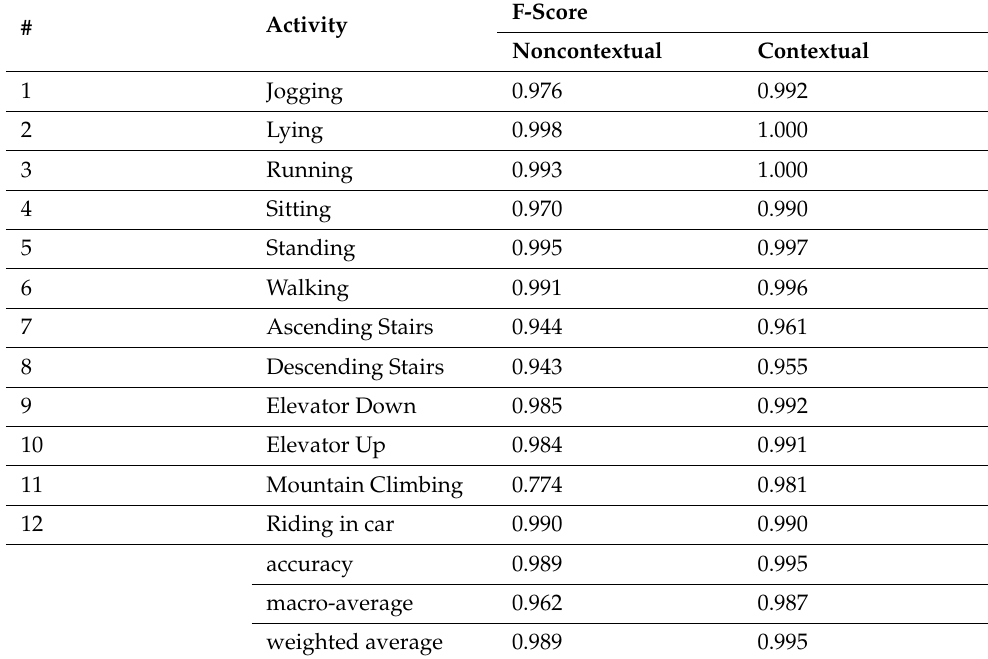
Table 5. Model accuracy by activity class.